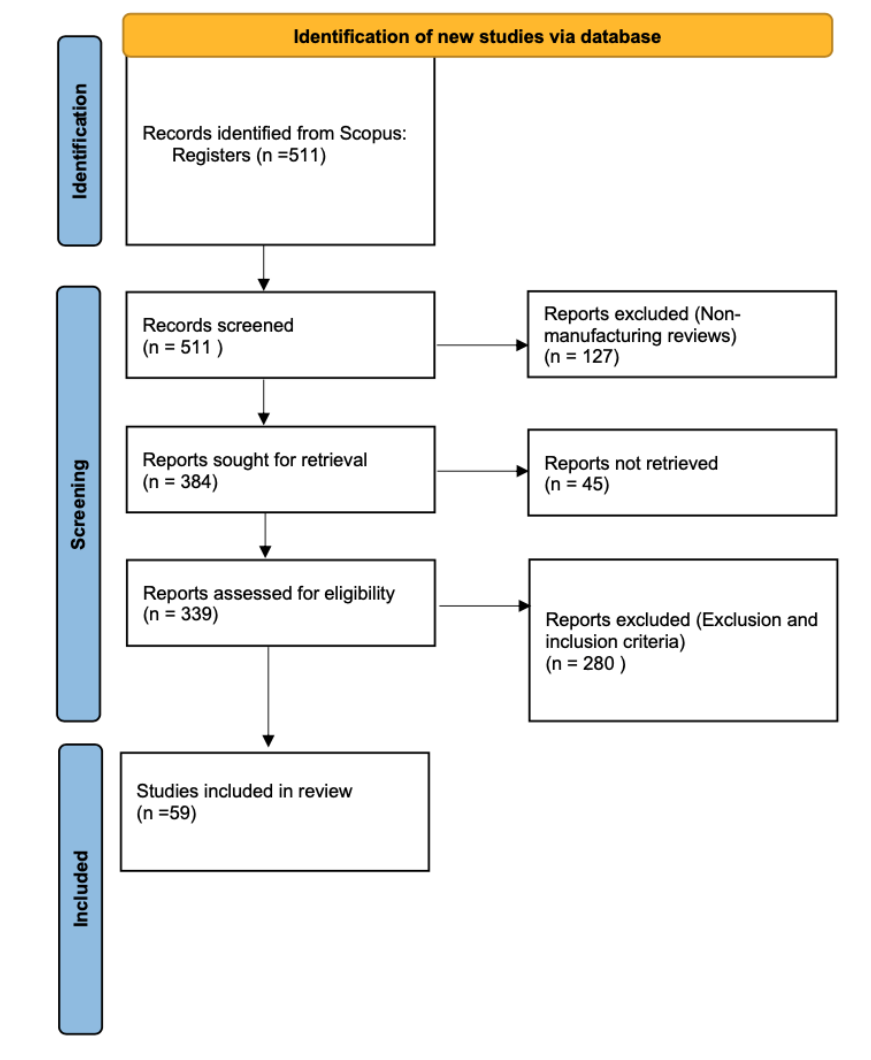
Figure 2. The figure shows different blocks being connected of the PRISMA methodology and represents how articles are decreased at each stage of the SLR process, selecting 59 out of 511 survey articles